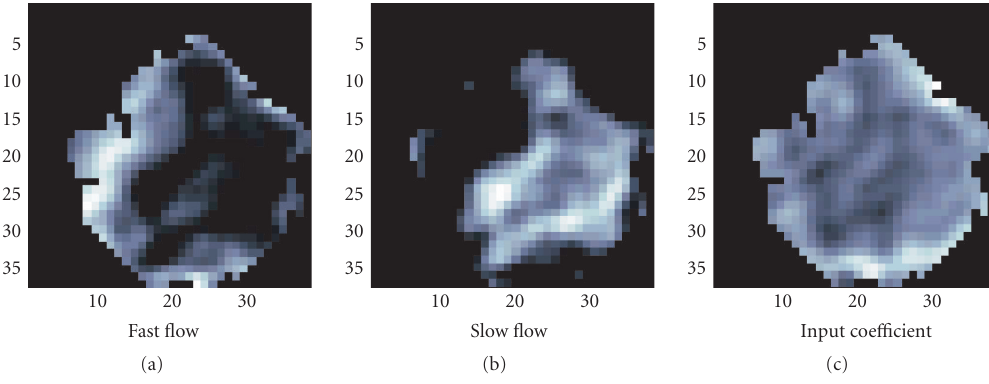
Figure 4: The reconstructed source factor images associated with fast and slow di ff usions as well as plasma input.